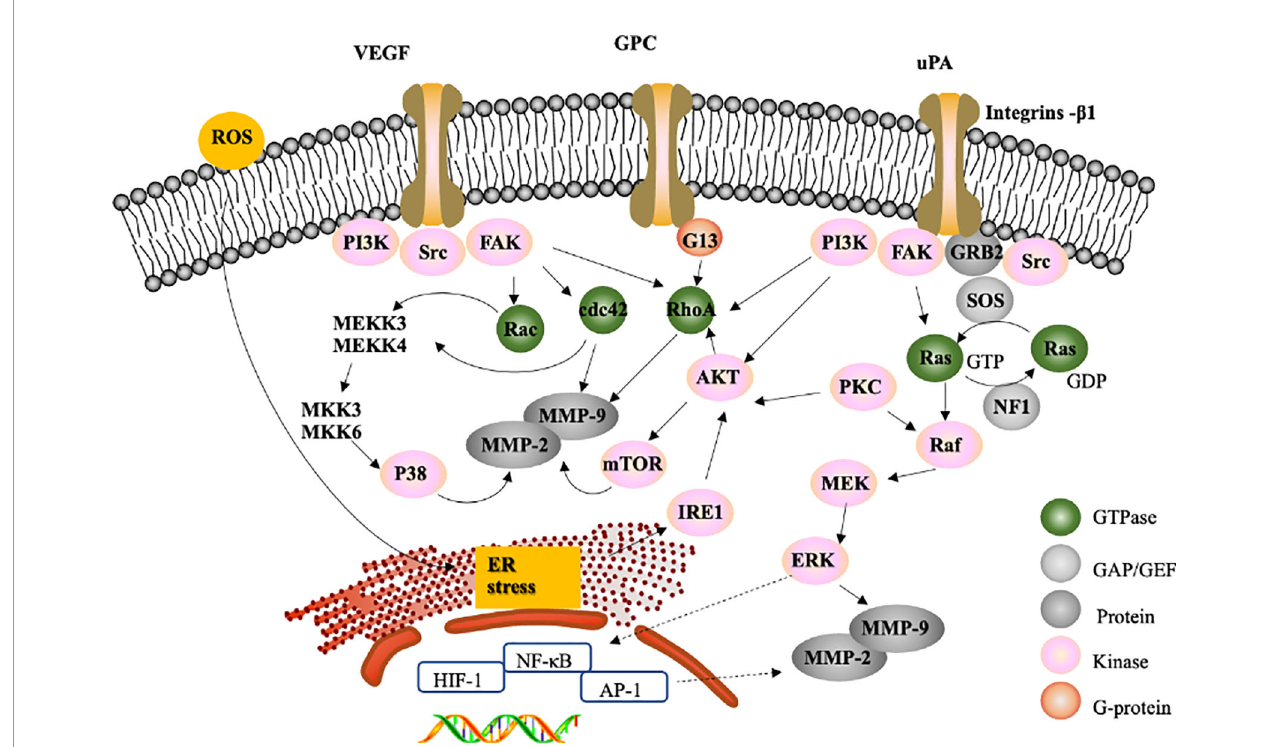
FIGURE 4 | Proposed signalling pathway for the inhibition of migration and invasion. The effect of natural compounds likely occurs through the inhibition of FAK, a GTPase family that regulates MMP-2/-9 expression through PI3K/Ark pathways, the P38 MAPK pathway or the Ras/Raf/Erk signalling pathway to inhibit migration and